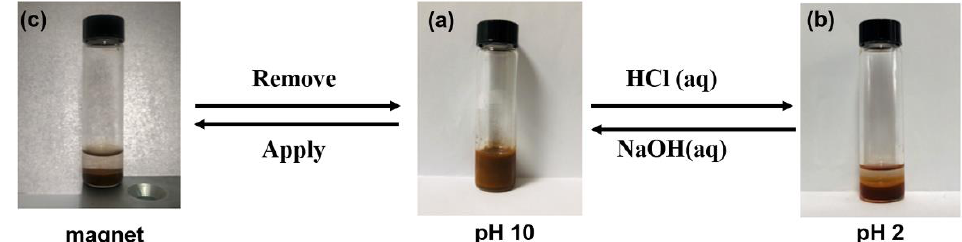
Figure 9. The pH and magnetism dual-responsive oil-in-water Pickering emulsion prepared by 1.0 wt% DC-Fe 3 O 4 nanoparticles. The Pickering emulsion sample at pH 10 ( a ), after reducing the pH to 2 ( b ), under an external magnetic field ( c ).